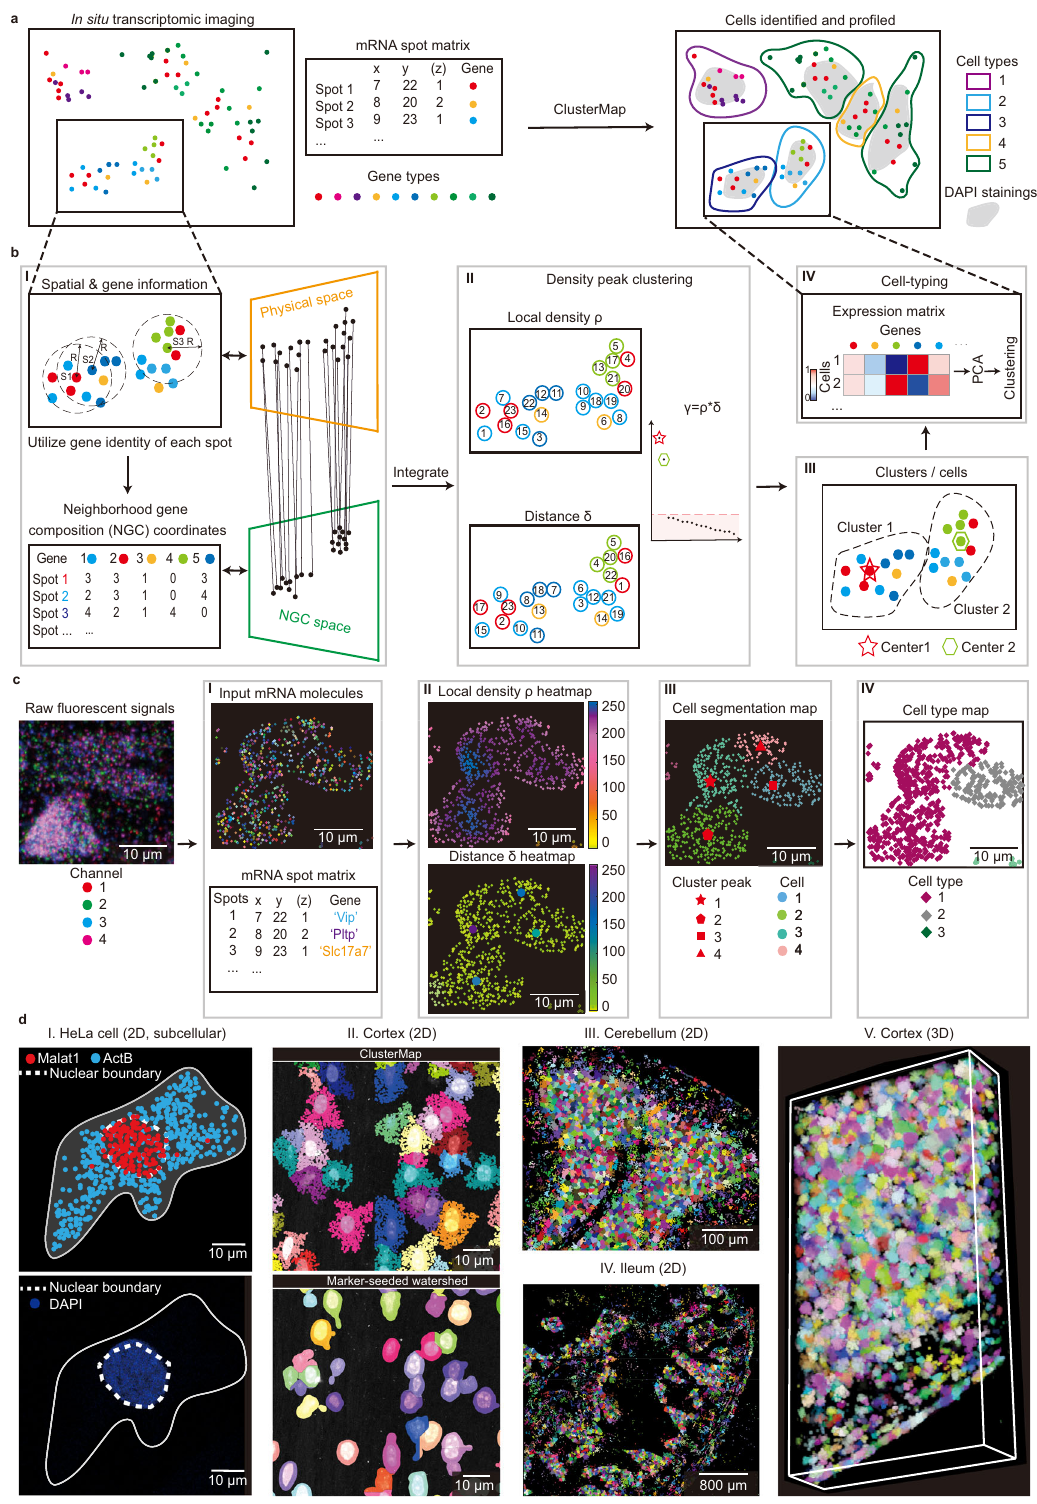
with ClusterMap procedures (Fig. 2a and Methods section). The results show clear cell segmentation even for strongly crowded mouse V1 cortex cells (Fig. 2b and Supplementary Fig. 3b). Additionally, we evaluated whether ClusterMap-identi fi ed cell center coordinates were within corresponding expert-labeled cell regions on eight STARmap mouse V1 datasets to validate its accuracy (Supplementary Fig. 3c). Notably, ClusterMap cell